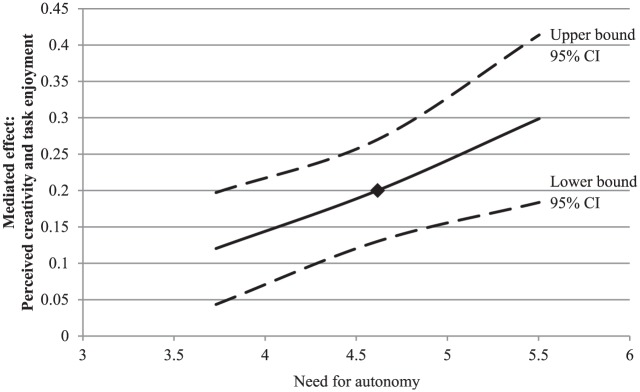
Study 1: A plot of the conditional indirect effect of input novelty
on task enjoyment through perceived creativity, conditioned on the
moderator (need for autonomy), with 95% confidence bands.Note. The square indicates the mean level of the
need strength. CI = confidence interval.